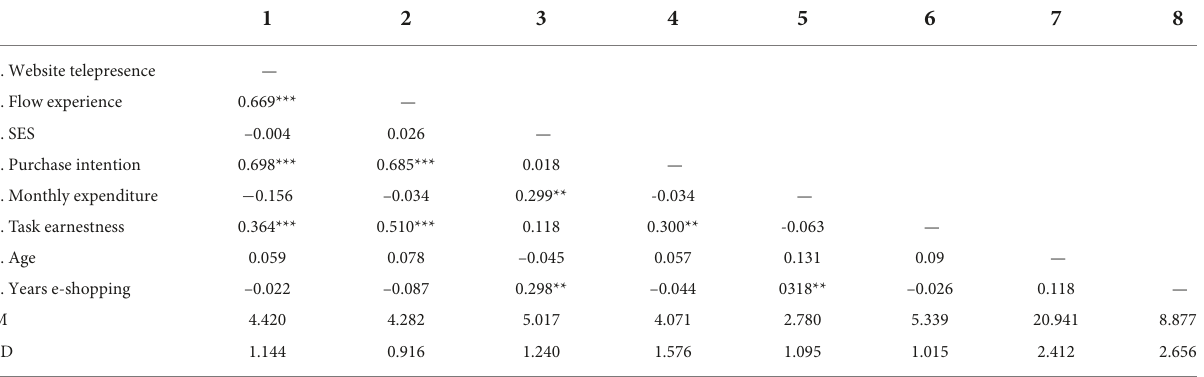
TABLE 1 Mean, standard deviation, and correlation matrix of each variable ( n =